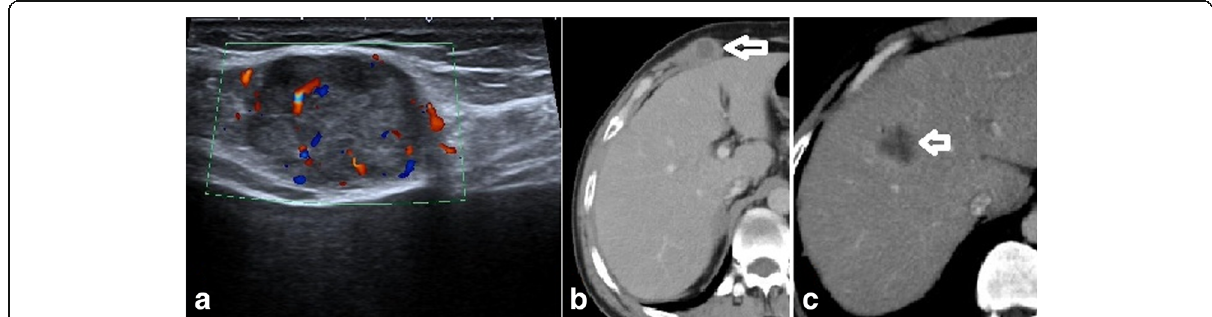
Fig. 9 a A color Doppler image showing a hypoechoic mass lesion infiltrating the abdominal wall muscles and showing internal vascularity. b An axial post-contrast CT image of the upper abdomen for the same patient showing a hypodense lesion (open white arrow) infiltrating the right rectus abdominus muscle. c An axial post-contrast CT image of the upper abdomen for the same patient showing a hypodense right hepatic lobe heterogeneously enhancing focal lesion that was incidentally found (open white arrow); this was histopathologically proven as a right rectus muscle metastatic nodule for a primary bronchogenic carcinoma